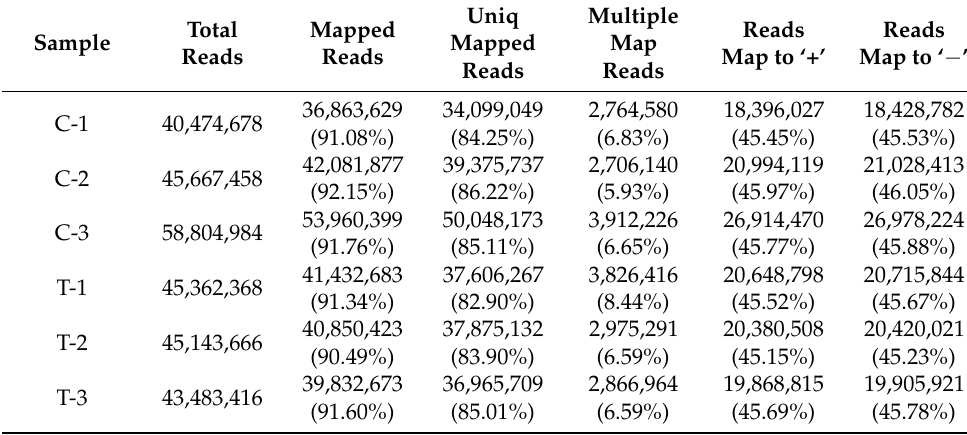
Table 3. Statistical summary of sequencing data and mapping to the zebrafish reference